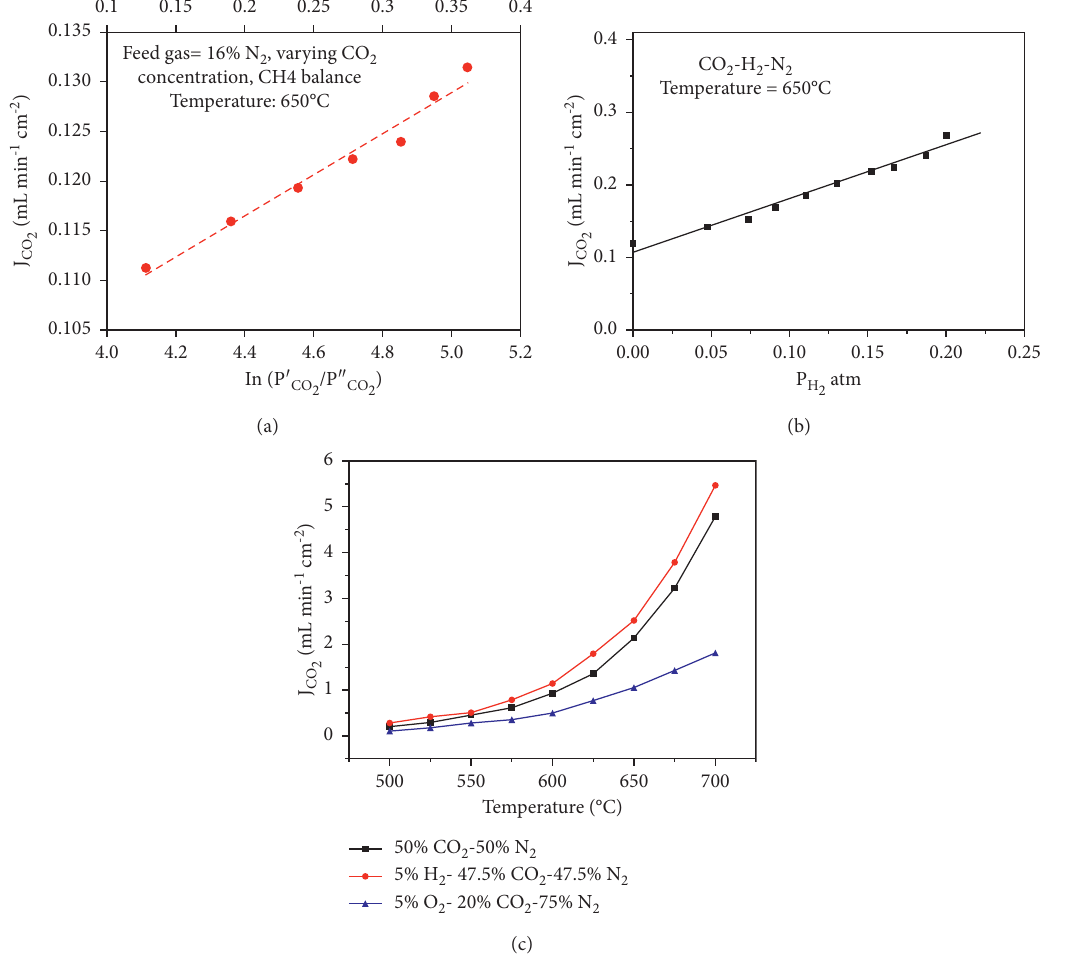
Figure 13: CO 2 flux density of SDC membrane (a) as a function of logarithm of CO 2 partial pressure [70], (b) as a function of H 2 partial pressure [26], and (c) in the presence and absence of H 2 [63].